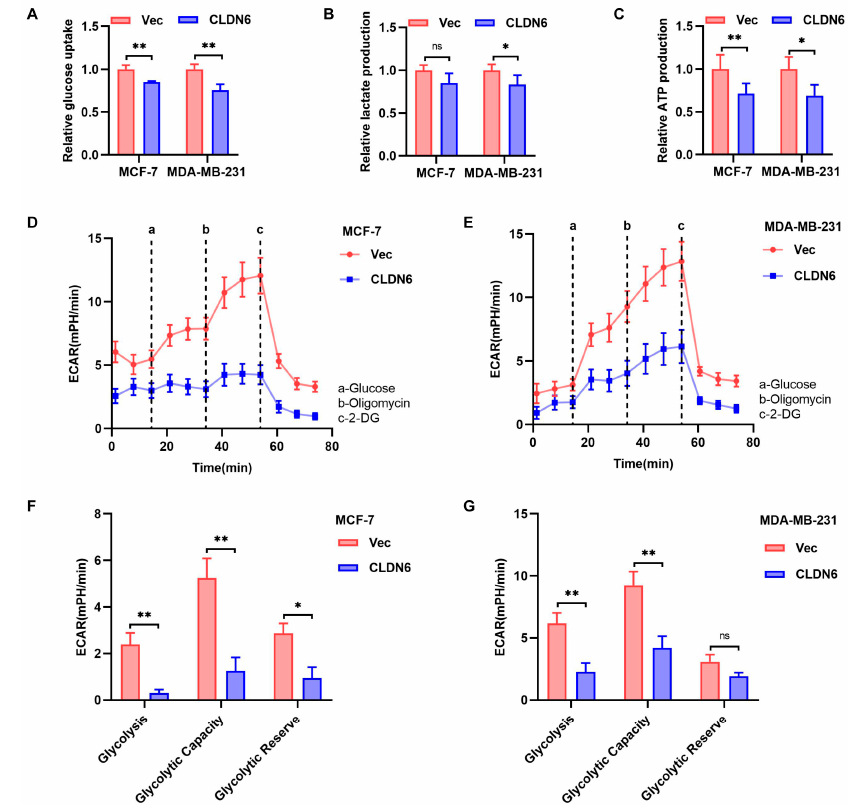
Figure 4. CLDN6 inhibits aerobic glycolysis in MCF–7 and MDA–MB–231 cells. Glucose uptake assays ( A ), lactate production assays ( B ), and ATP production assays ( C ) with MCF–7 and MDA–MB–231 cells expressing vector or CLDN6. ( D , E ) Diagram of ECAR results of MCF–7/CLDN6, MDA–MB–231/CLDN6, and their controls were obtained by Seahorse extracellular flux analyzer. ( F , G ) Comparison of glycolysis, glycolytic capacity, and glycolytic reserve in MCF–7/CLDN6 and MDA–MB–231/CLDN6 and the respective control cells. Glycolysis = (maximum rate measurement before Oligomycin injection) − (last rate measurement before glucose injection); Glycolytic capacity = (maximum rate measurement after Oligomycin injection) − (last rate measurement before glucose injection); Glycolytic reserve = (Glycolytic capacity) − (Glycolysis). * p < 0.05, ** p < 0.01.